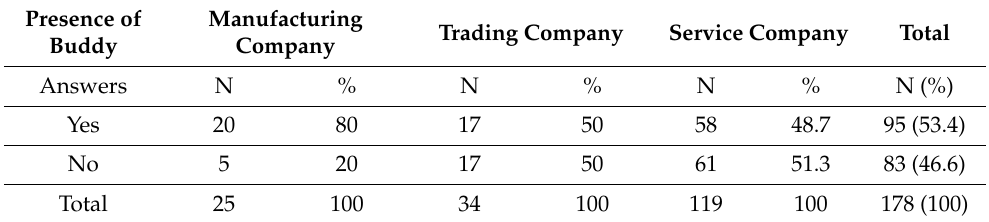
Table 8. The type of company and assignment of a buddy (contingency table). Presence of